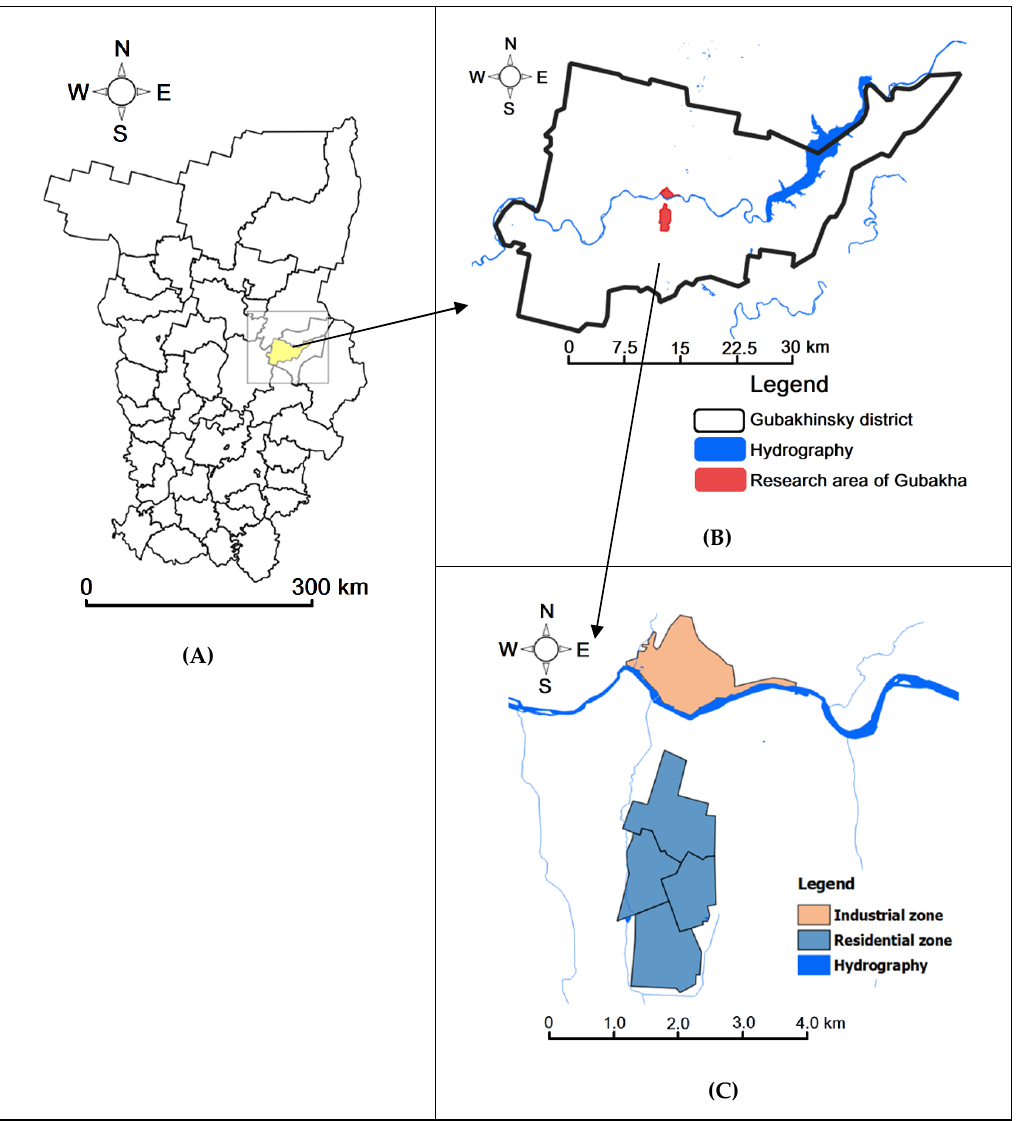
Figure 1. Research area: ( A ) Map of Perm region. ( B ) Gubskhinsky district. ( C ) Research zones of